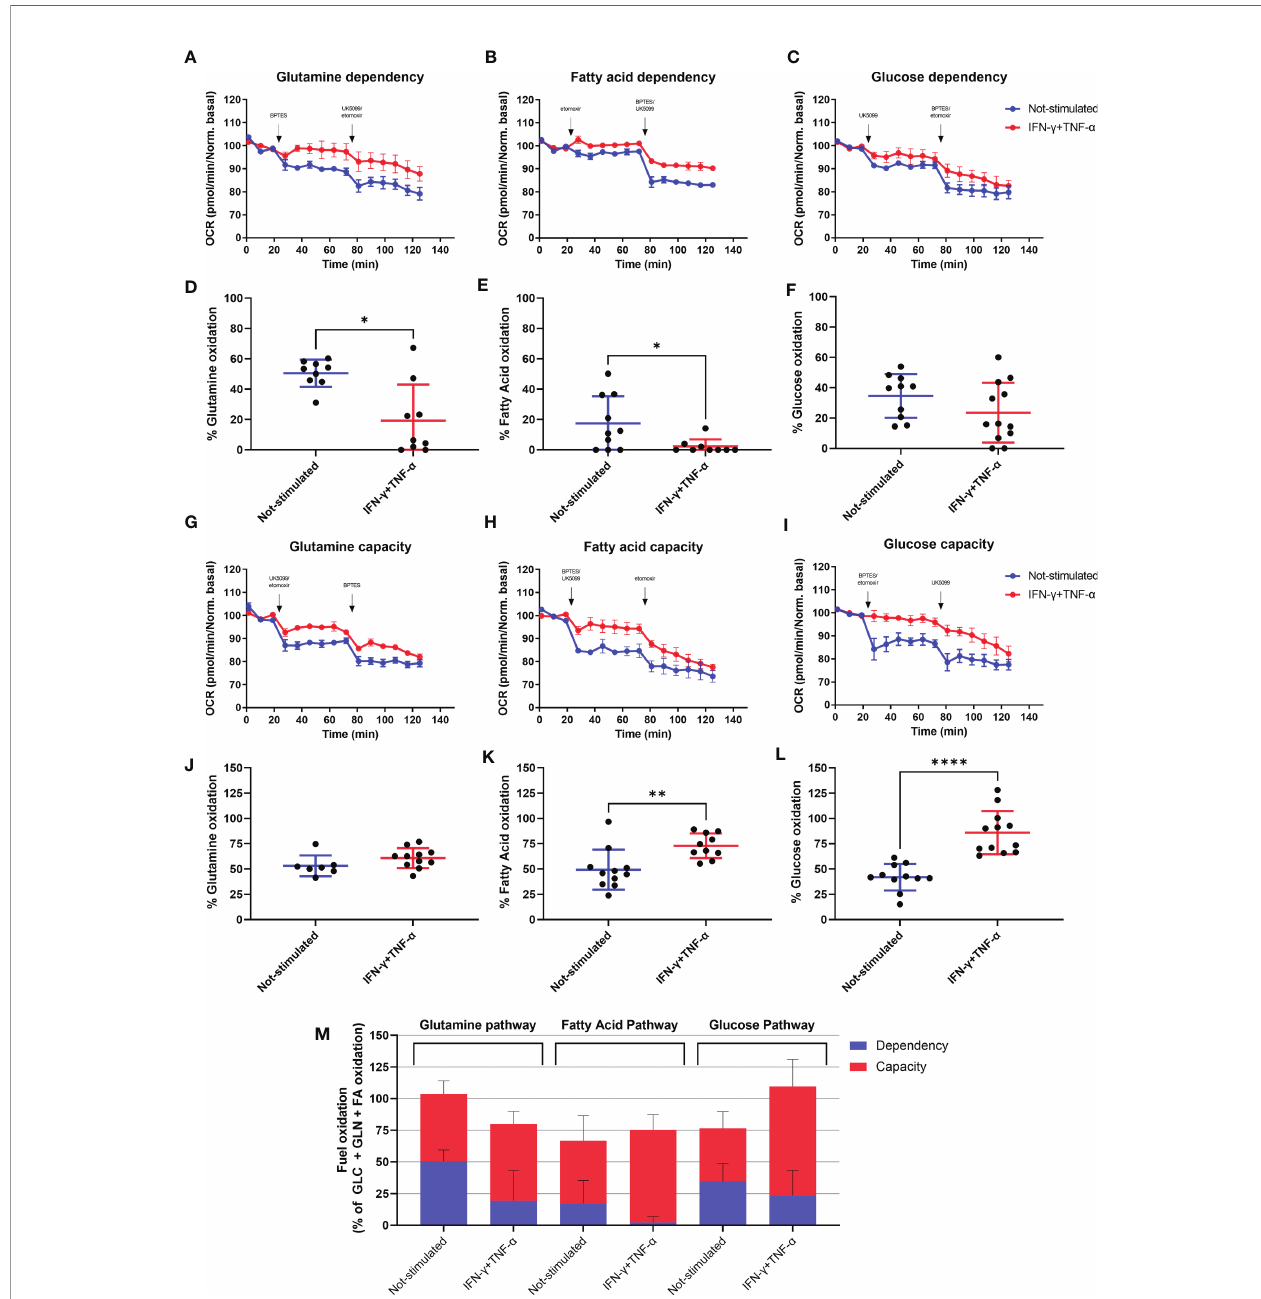
FIGURE 6 | Assessment of AC-16 fuel oxidation in response to IFN- g and TNF- a stimulation. Oxygen consumption rate of 48h IFN- g (10 ng/ml) and TNF- a (5 ng/ ml)-stimulated AC-16 cells was obtained in Seahorse XFe24 Analyzer. Arrows show injection of inhibitors (combined or not) of molecules speci fi c to different fuel oxidation pathways, such as; BPTES, inhibitor of glutaminase GLS1 (KGA, glutamine pathway), etomoxir, inhibitor of carnitine palmitoyltransferase-1 (CPT-1, fatty acid pathway) and UK5099, inhibitor of the mitochondrial pyruvate carrier (MPC, glucose pathway). (A – F) OCR dependency of glutamine, fatty acid oxidation and glucose. (G – L) OCR capacity of glutamine, fatty acid oxidation and glucose. (M) Global fuel oxidation. Standard error of the mean in line graphs. Standard deviation is from ≥ 9 independent measurements. *p < 0.05; **p < 0.01; ****p < 0.0001 Mann-Whitney